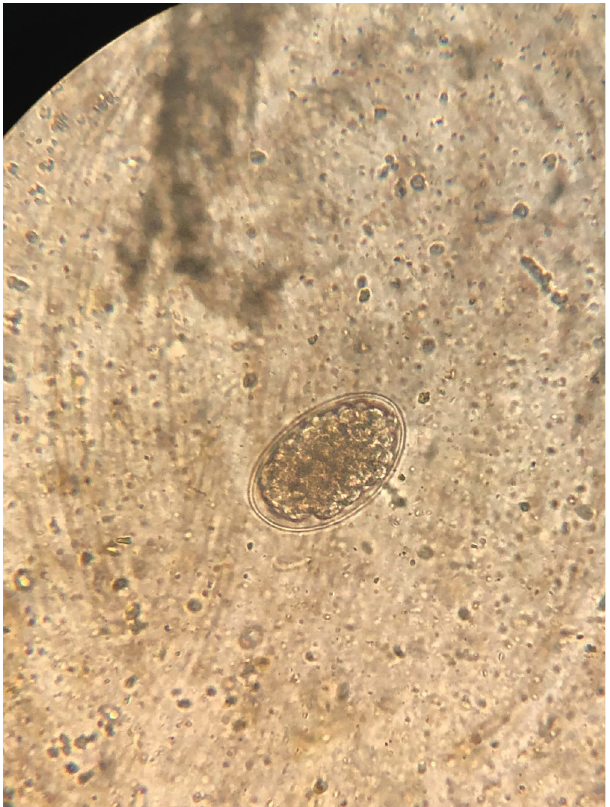
Figure 1: Trichostrongylidae : the egg is ovoid, pointed at one end, yellow-greyish in color, and thin-walled. The morula inside may consist of a variable number of blastomeres. Size: 75 – 95 μ m × 40 – 50 μ